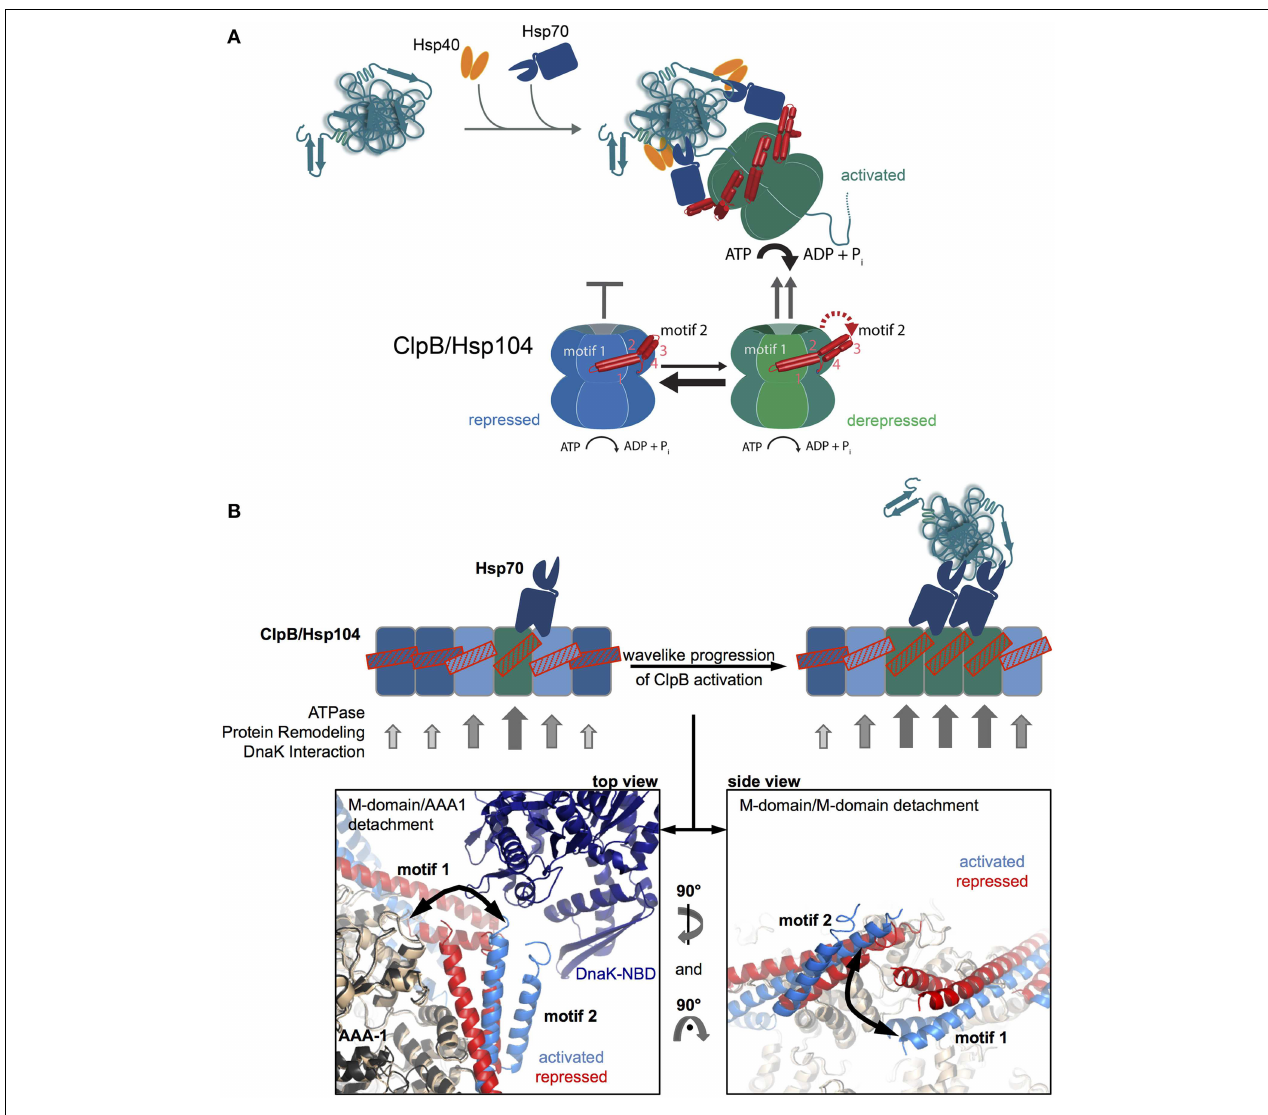
FIGURE 3 | M-domains control ClpB/Hsp104 activity and Hsp70 cooperation. (A) Disaggregating chaperones bind in a hierarchical order to protein aggregates involving Hsp40 binding as first and ClpB/Hsp104 recruitment as latest step. Hsp70 activates ClpB/Hsp104 at the surface of protein aggregates. ClpB/Hsp104 activity is controlled by its uniqueM domain. M-domain attachment to AAA-1 represses ClpB/Hsp104 motor activity (repressed state). Detachment of motif2 from AAA-1 (derepressed state) and subsequent substrate engagement lead to full ClpB activation (activated state). Hsp70 only interacts with detached M-domains, shifting the equilibrium from repressed to derepressed activity states of ClpB/Hsp104 and coupling ClpB/Hsp104 recruitment to activation. (B) Wavelike progression of ClpB/Hsp104 activation upon an initial Hsp70 encounter.